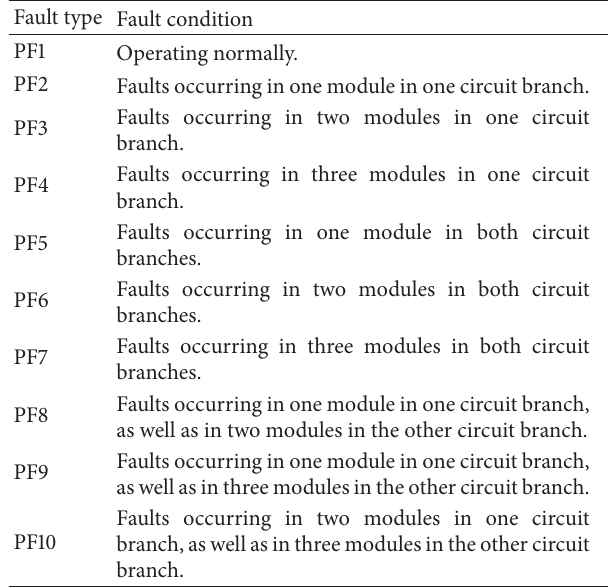
Table 1: Photovoltaic power generation system fault